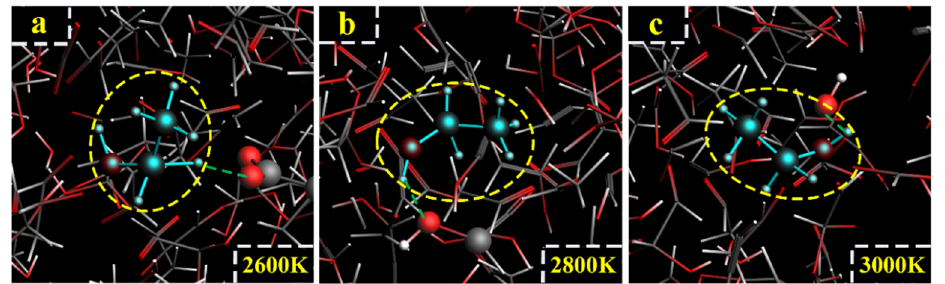
Figure 23. Path VII for the production of ethanol. ( a – c ) are the procedure of acetaldehyde and 2,2-dihydroxyacetaldehyde to produce ethanol at 3000 K.